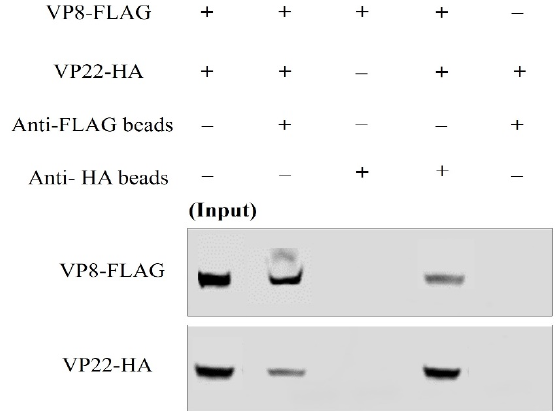
Figure 7. VP8 and VP22 interact outside the context of infection in transfected cells. COS-7 cells were transfected with VP8-FLAG and/or VP22-HA plasmids. The cells were lysed at 24 h post-transfection, and incubated with Anti-FLAG M2 Affinity Gel or anti-HA agarose. VP8 and VP22 were detected by Western blotting with monoclonal mouse anti-FLAG and polyclonal rabbit anti-HA antibodies, followed by IRDye 680RD goat anti-mouse IgG and IRDye 800RD goat anti-rabbit IgG, respectively. VP22 was precipitated with VP8 and Anti-FLAG M2 Affinity Gel, while VP8 was precipitated with VP22 and anti-HA agarose.